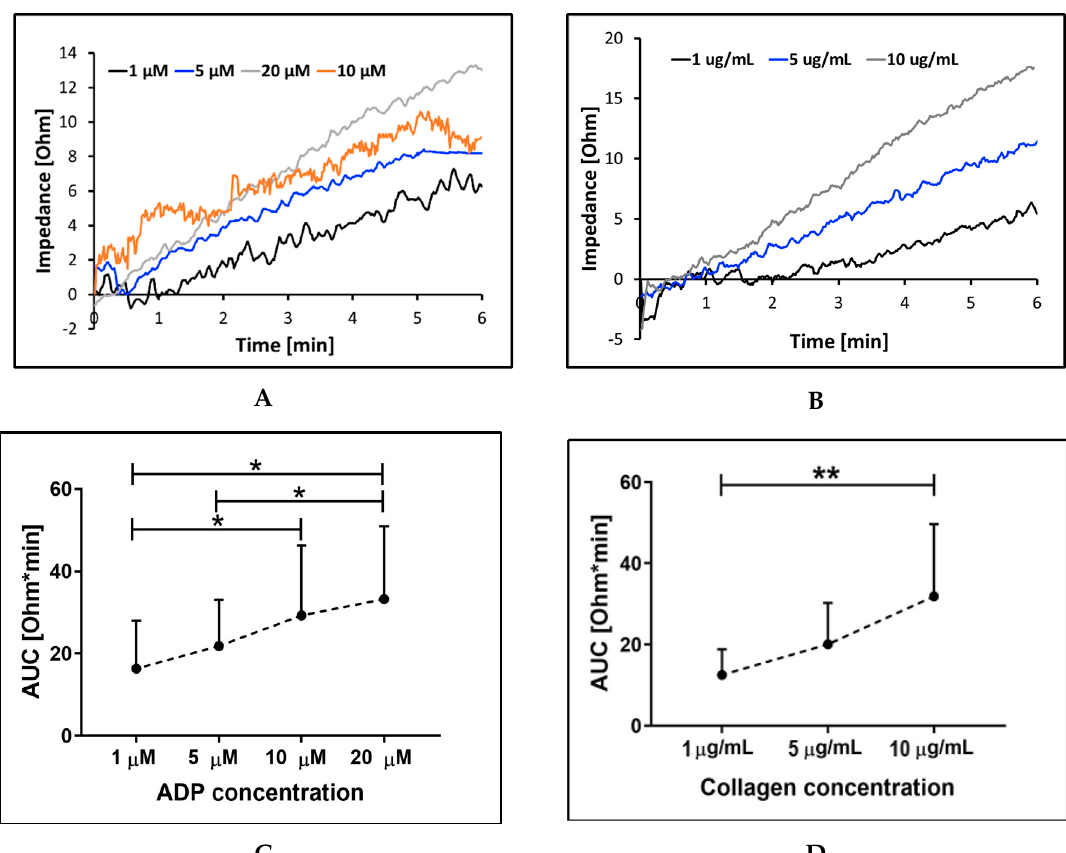
Figure 5. Platelet aggregation induced by di ff erent concentrations of ADP ( A , C ) and collagen ( B , D ) in hirudin-anticoagulated whole blood: AUC—area under the curve. ( A , B )—illustrative curves of ADP- and collagen-induced aggregation recorded by the MICELI. Data from 4 independent experiments using blood samples from 4 di ff erent individuals are reported. Mean ± SD as error bars of AUC are indicated, ANOVA: no asterisk— p > 0.05; *— p < 0.05; **— p < 0.01.